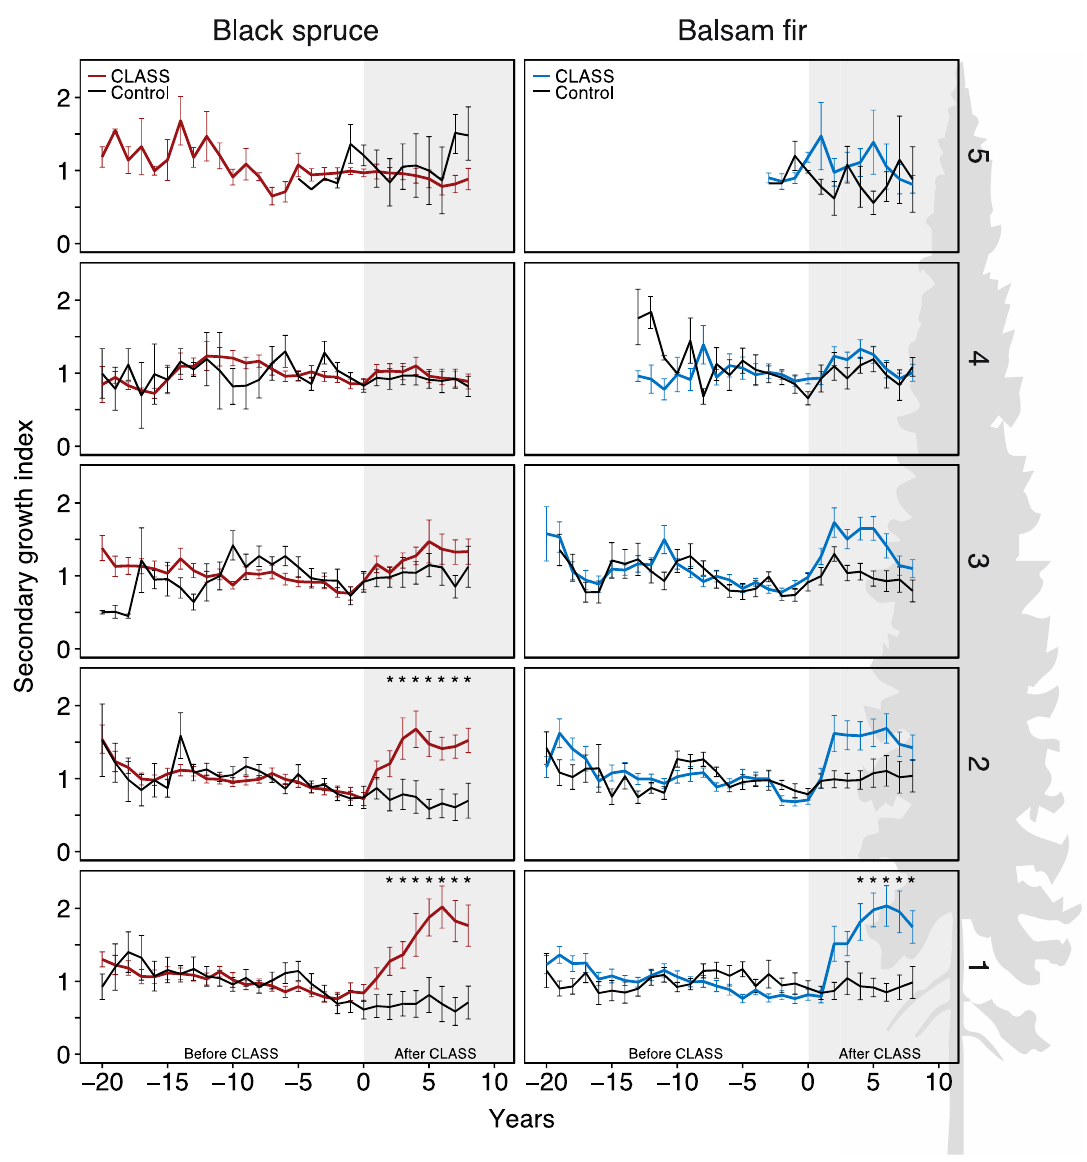
Figure 4. Mean branch secondary growth index (± se) in the five sections of the live crown for black spruce and balsam fir before and after CLASS. The grey area represents the years post-treatment, with Year 0 being the treatment year. Stars indicate a significant difference between the treated and control trees for a given year, obtained from the contrasts. The missing data for the years before treatment for branches from the highest two sections indicates that these are newly formed branches.